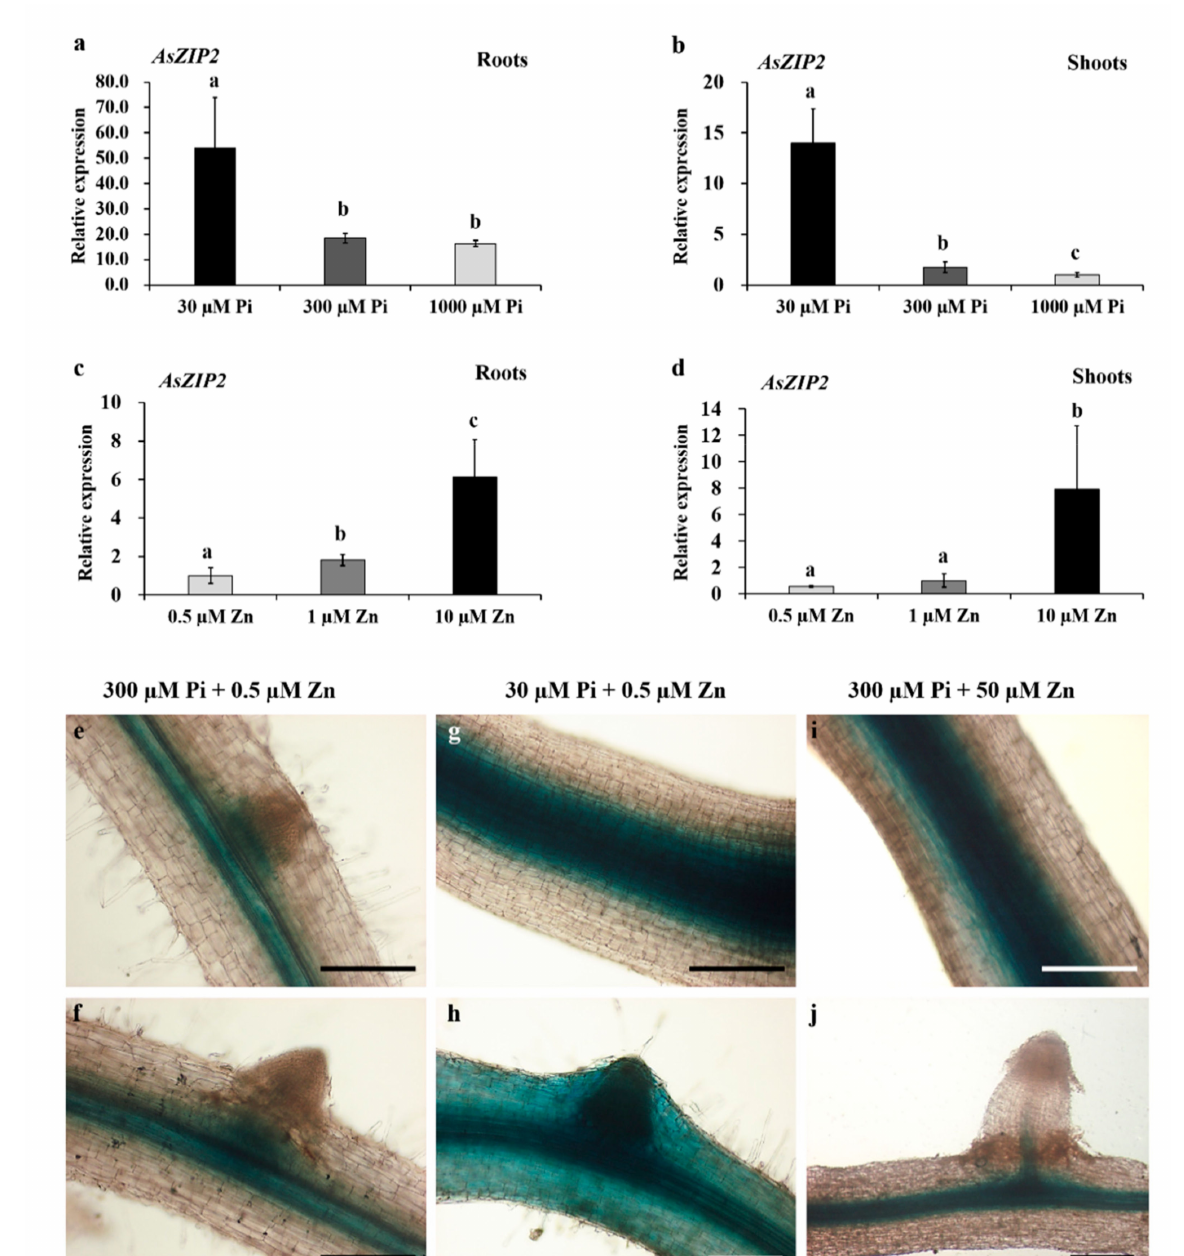
Figure 3. The expression patterns of AsZIP2 in A. sinicus . ( a – d ) Relative expression of AsZIP2 in response to external Pi and Zn treatments, as determined by real time qRT-PCR. 56-day-old A. sinicus plants were grown in sand cultures supplied with the indicated nutrient concentrations. AsActin from A. sinicus served as an endogenous control for normalization. Data are shown as means ± SD of three biological replicates. Averages with the different letters are significantly different at p < 0.05, based on Duncan’s multiple range test. ( e – j ) Histochemical localization in pAsZIP2::GUS transgenic A. sinicus hairy roots treated with different Pi and Zn concentrations. Positive GUS staining of the primary ( e , g , i ) and lateral ( f , h , j ) roots treated with 30 or 300 µ M phosphate, grown under low Zn (0.5 µ M) or moderately high Zn (50 µ M) conditions described in each panel. ( e ) The primary root with a primordium; ( g , i ) The strong GUS staining of the central cylinder of primary roots. ( h ) The GUS signal is also present in the root epidermis, cortex, and primordium during Pi starvation. Scale bars, 100 µ